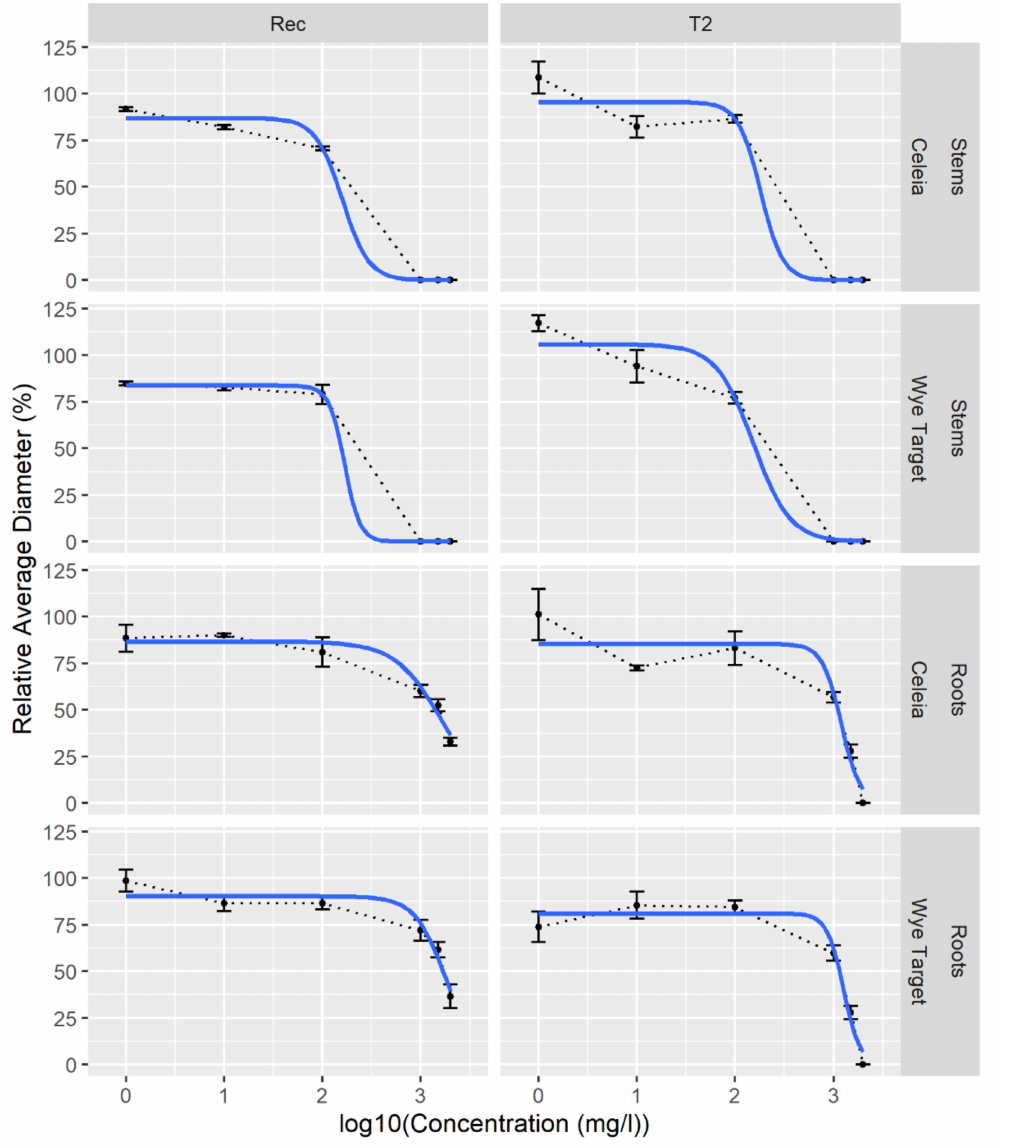
Figure 5. Polyphenolic extracts from hop roots and stems display antifungal activity against V. nonalfalfae . Using a nonlinear regression model, the relative average colony diameter (in % of solvent control) was analyzed depending on the logarithmic phenolic extract concentration. Rec, mild pathotype of V. nonalfalfae ; T2, lethal pathotype of V. nonalfalfae ; Celeia, VW susceptible hop; Wye Target, VW resistant